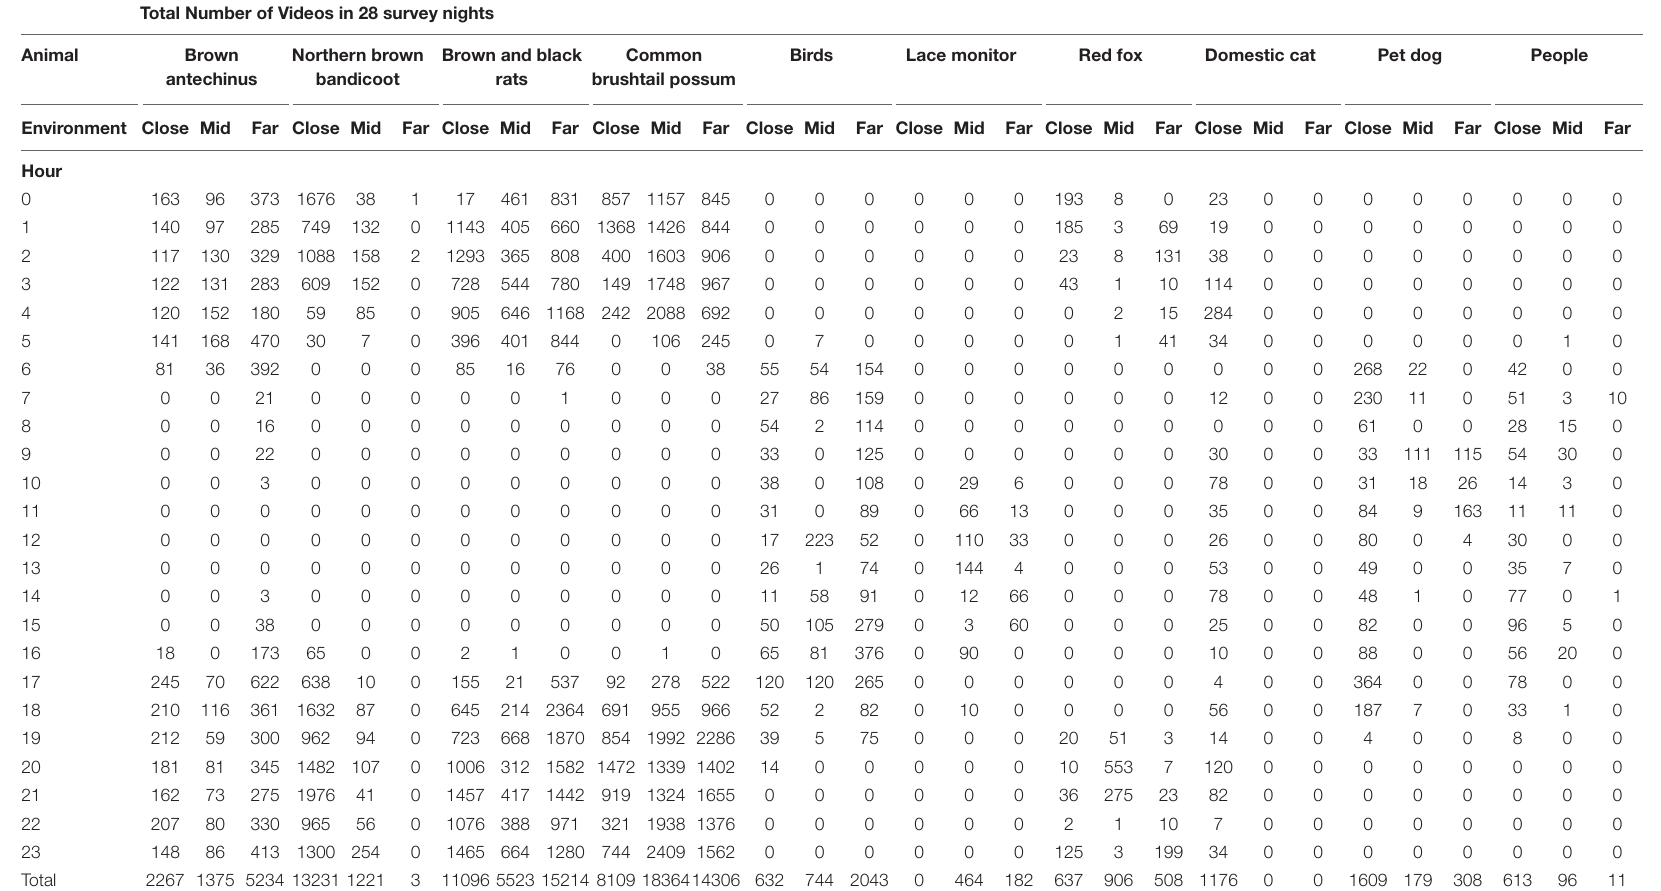
TABLE 1 | Total number of videos and photos for each hour (0–23) for the most consistently observed potential prey species and their potential stressors, at each of the three environments along an urban disturbance gradient (close, mid, and